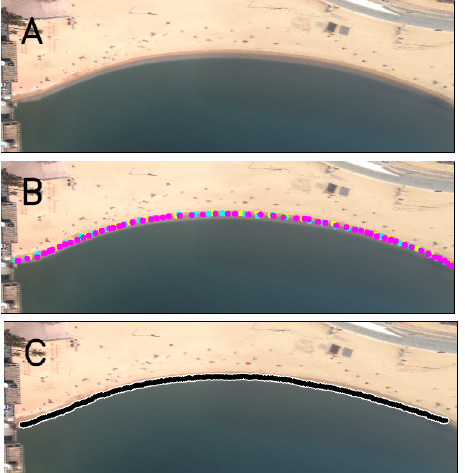
Figure 12. Examples of ( A ) original planview, ( B ) manual shorelines digitized by the three users (in different colors), ( C ) filtered shoreline (white and black) of beach BCN4 on 15 March 2017 at 12 h. The images do not have the original size of the planview but a zoom is applied to facilitate the visualization. In ( C ), the white points is the filtered shoreline, while the points of the filtered shoreline where E f < 10 px are in black.